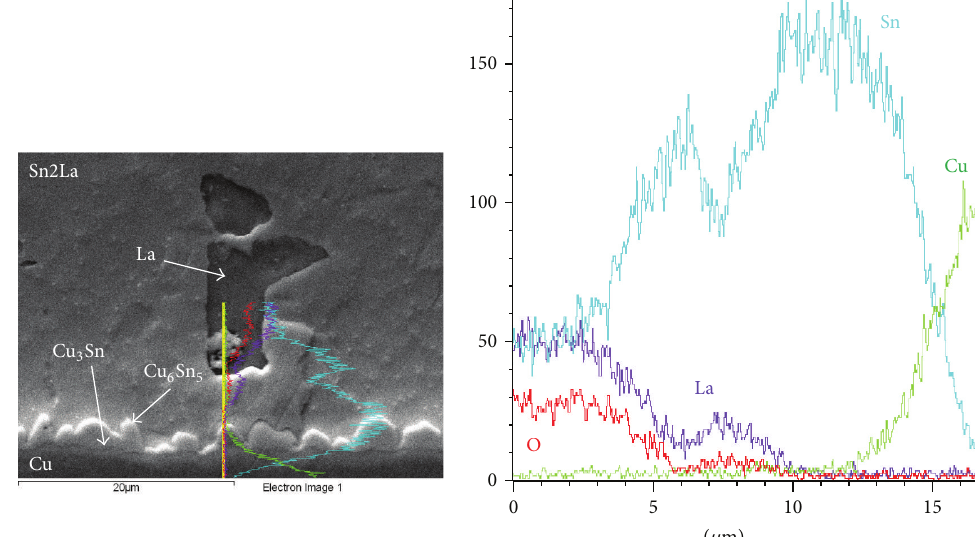
Figure 21: Microstructure of Cu/Sn2La boundary (SEM) with concentration profiles of La, Cu, Sn, and O elements.